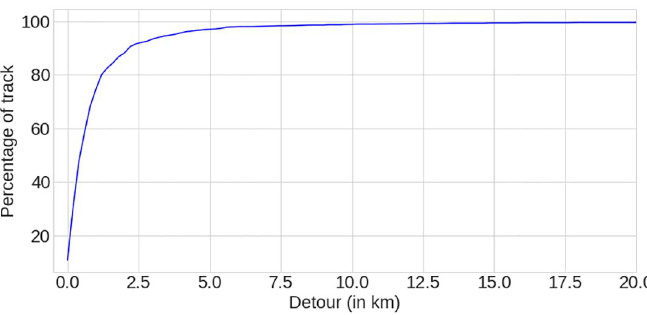
Fig 4. CDF of the differences of distances between experienced and computed